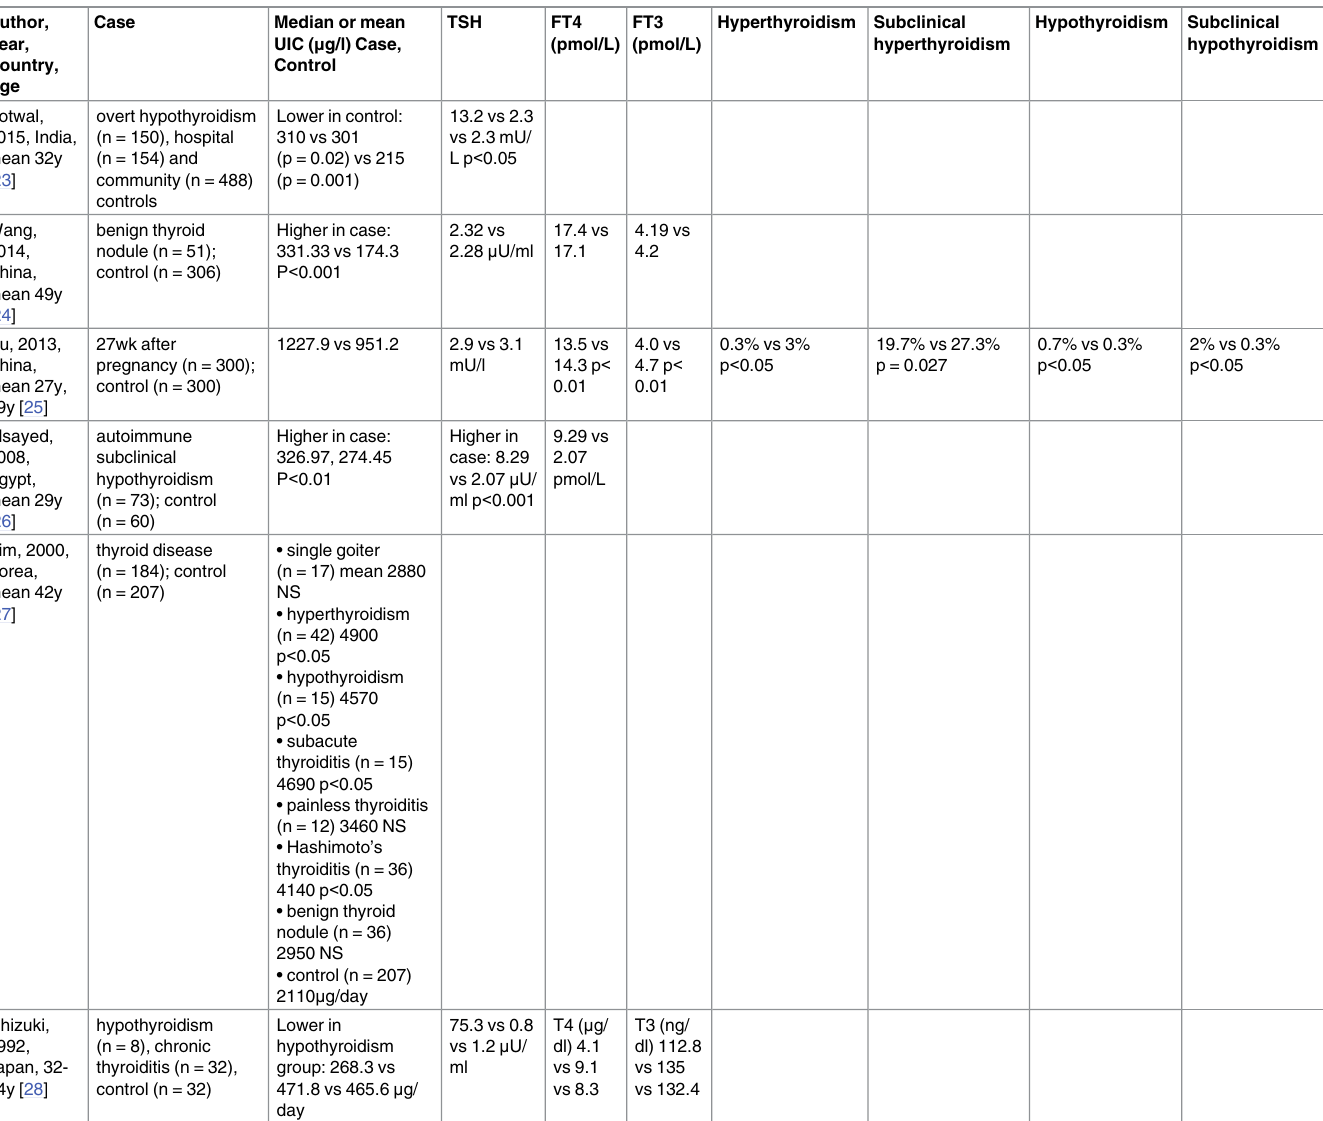
Table 2. Case-control studies, including populations with excessmean or median urinary iodine concentration